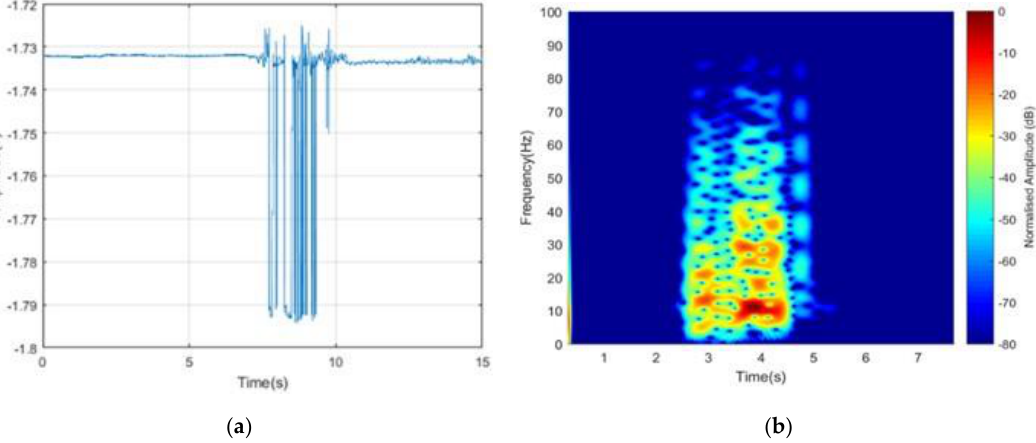
Figure 9. ( a ) Received signal (Signal 1) in time domain at the output of ADC, and ( b ) its joint time–frequency representation of the sampled signal (5–13 s) denoted as target signature.